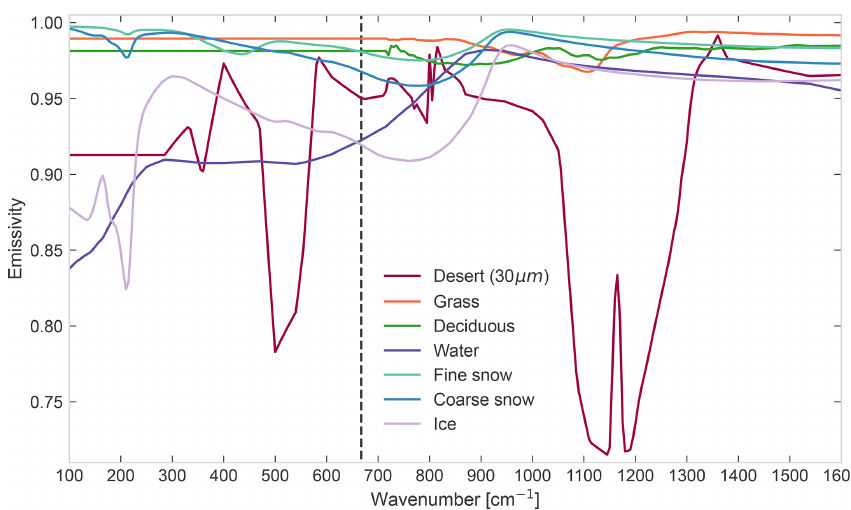
Figure 1. Spectral surface emissivity between 100 and 1600cm − 1 for 7 out of the 11 surface types in Huang et al. (2016). The desert subtype is r e = 30µm, as used in the FEES. The far-infrared is defined in this work to the left of the dashed